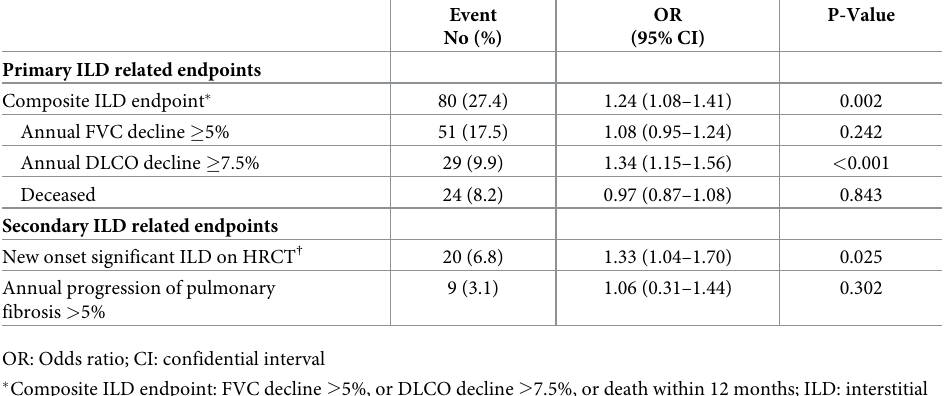
Table 3. CX 3 CL1 association with the primary and secondary endpoints by univariable logistic regression